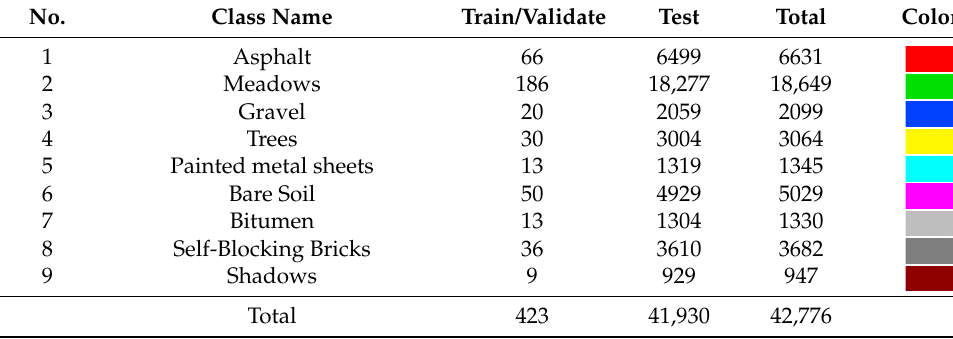
Table 2. The training and testing sample numbers and colors of the UP